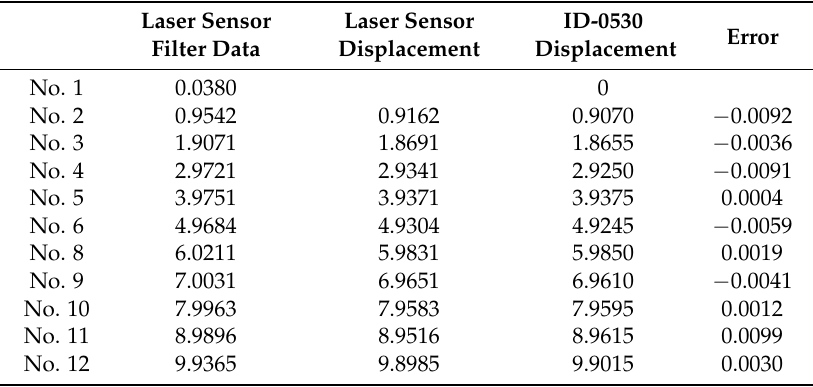
Table 4. Experimental of actual measurement parameters of sensors